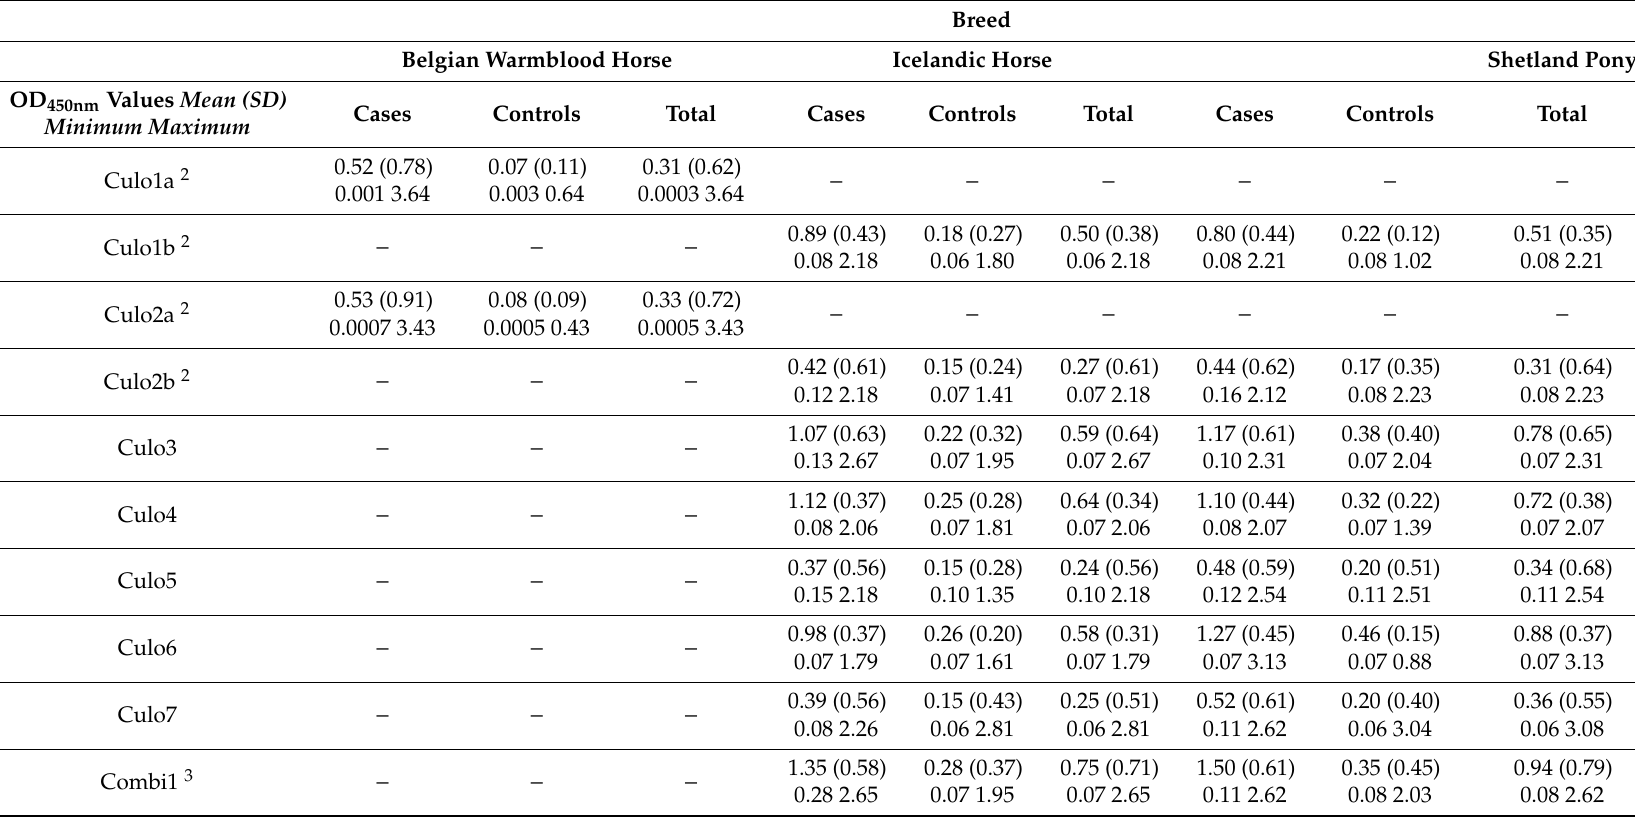
Table A1. Descriptive statistics (mean, standard deviation, minimum and maximum) of IgE levels (OD 450nm values) and log transformed IgE levels used in the GWA